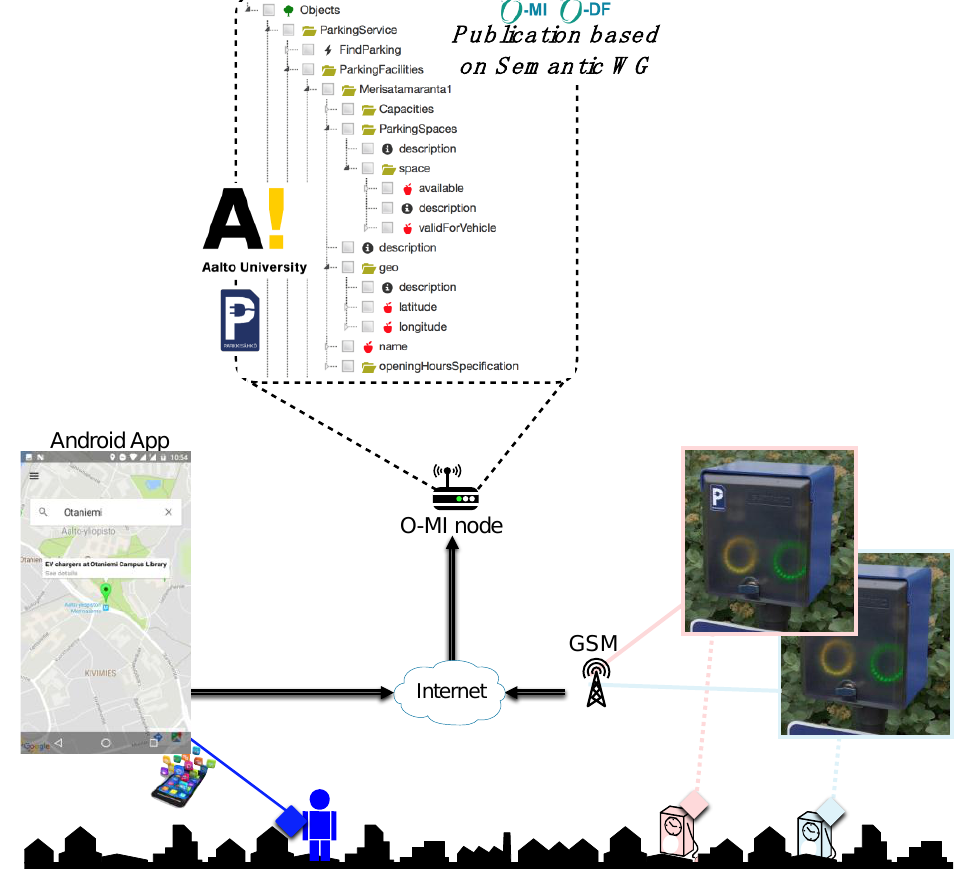
Figure 3. Parking and charging service overview.